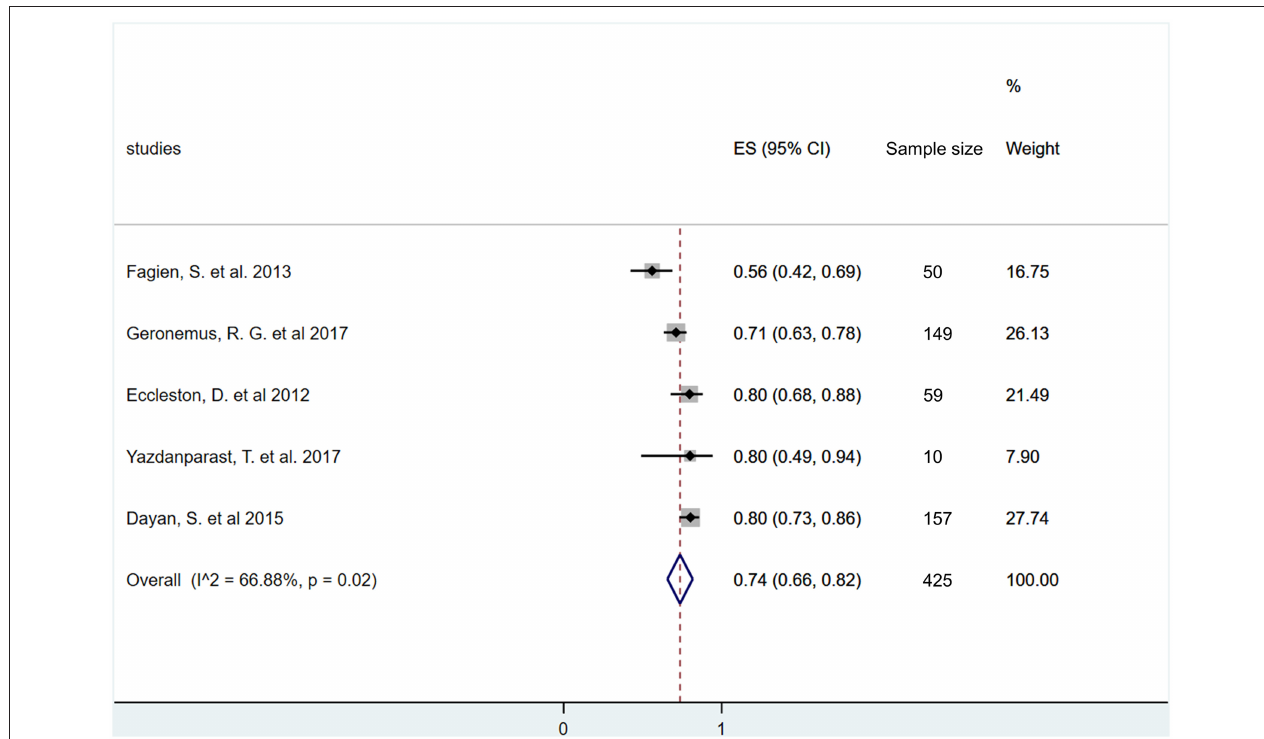
FIGURE 6 | Estimate of overall rate of responders at 6 months after treatment. Overall, 74% (95% CI: 66–82%) of included participants had at least one grade improvement on a validated lip fullness scale after 6 months of initial